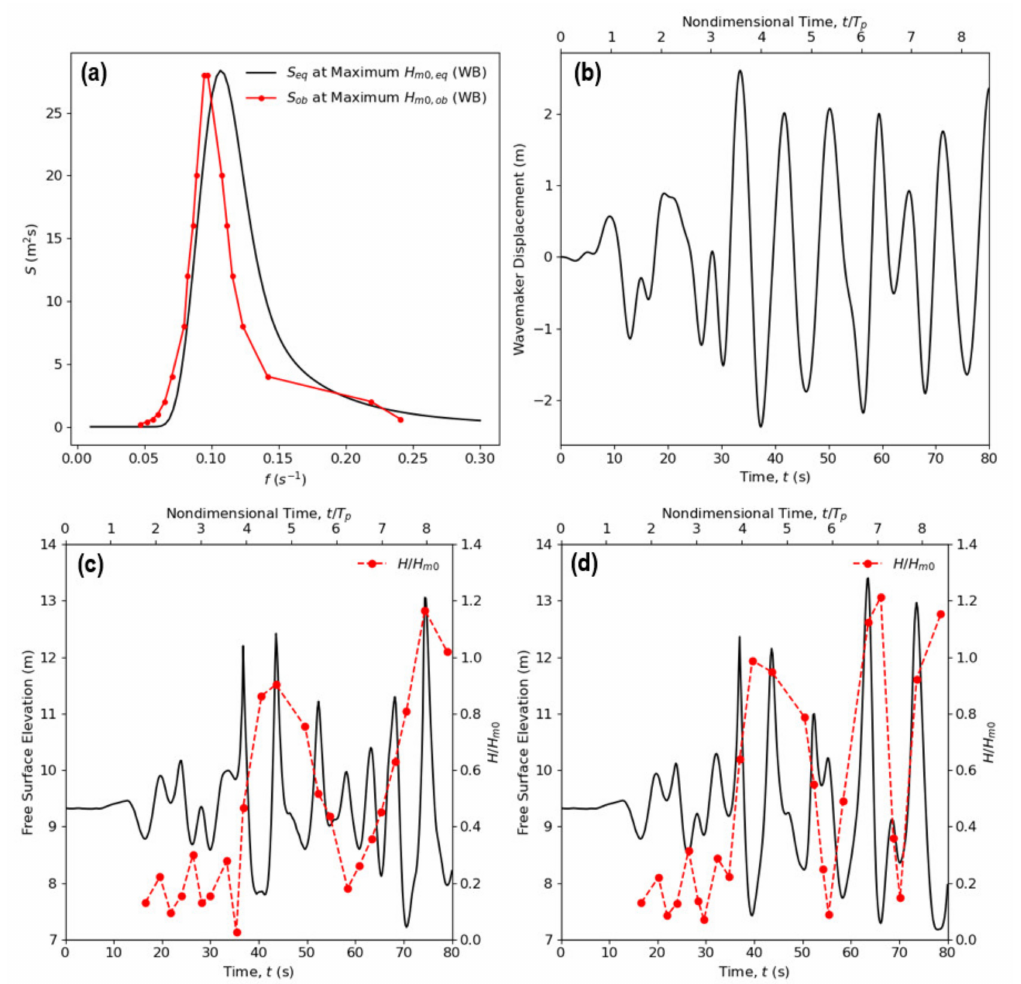
Figure 12. ( a ) Wave spectrum adopted for the generation of hurricane waves with ( b ) associated wavemaker displacement time history; free surface elevation and wave heights relative to H m 0 located 40 m from the midpoint of the wavemaker for ( c ) d w = 4 m and ( d ) d w = 5 m also